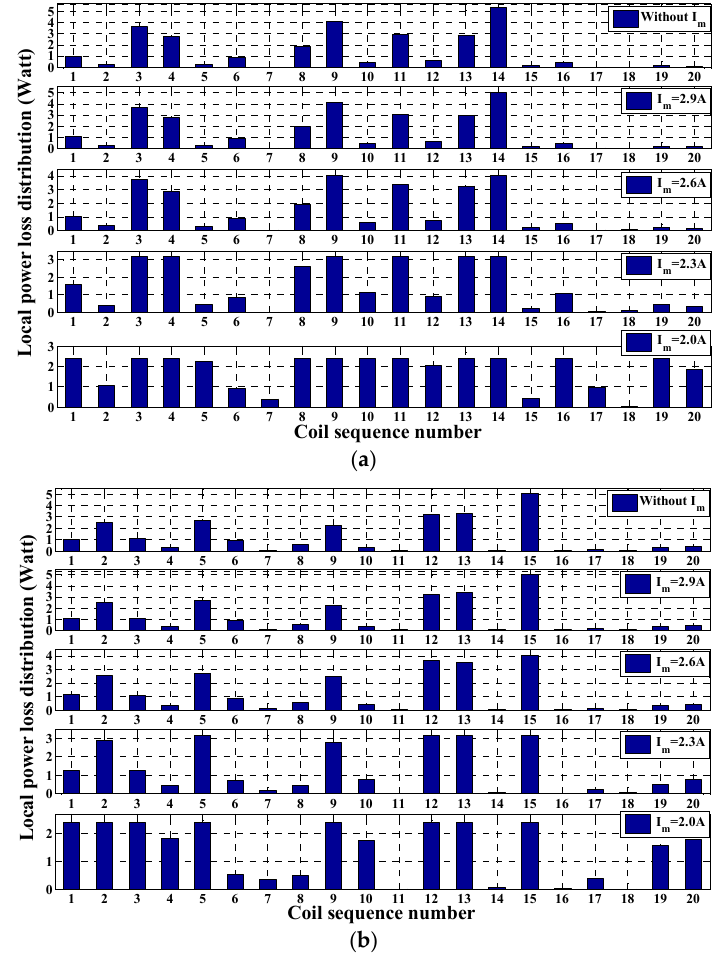
Figure 9. Local power loss distribution in position ( a ) x = − 4.244 mm and ( b ) x = 4.244 mm when commutations are optimized without boundary constraint I m , with boundary constraint I m = 2.9 A, 2.6 A, 2.3 A, and 2.0 A, respectively.